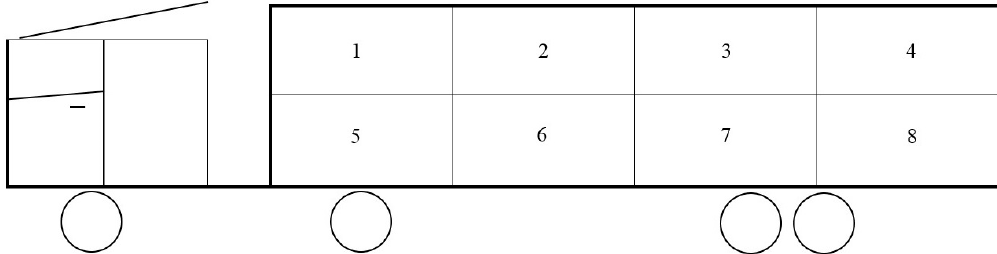
Table 1. Used transport combinations during the monitoring.